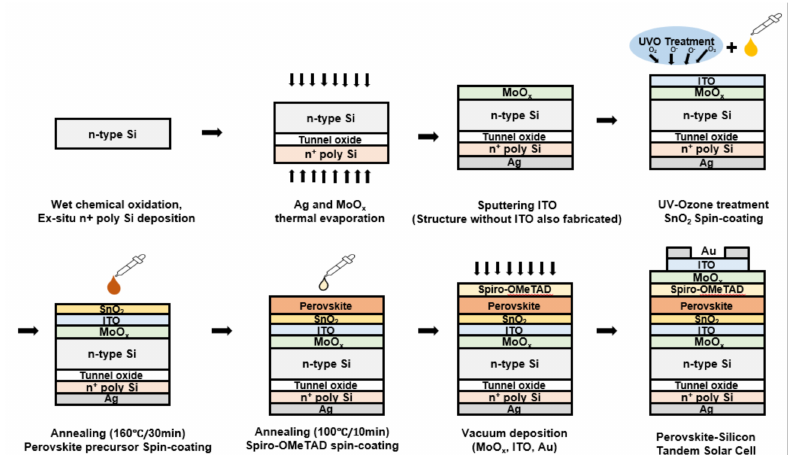
Figure 2. Schematic illustration for the fabrication of monolithic perovskite-carrier selective contact silicon tandem solar